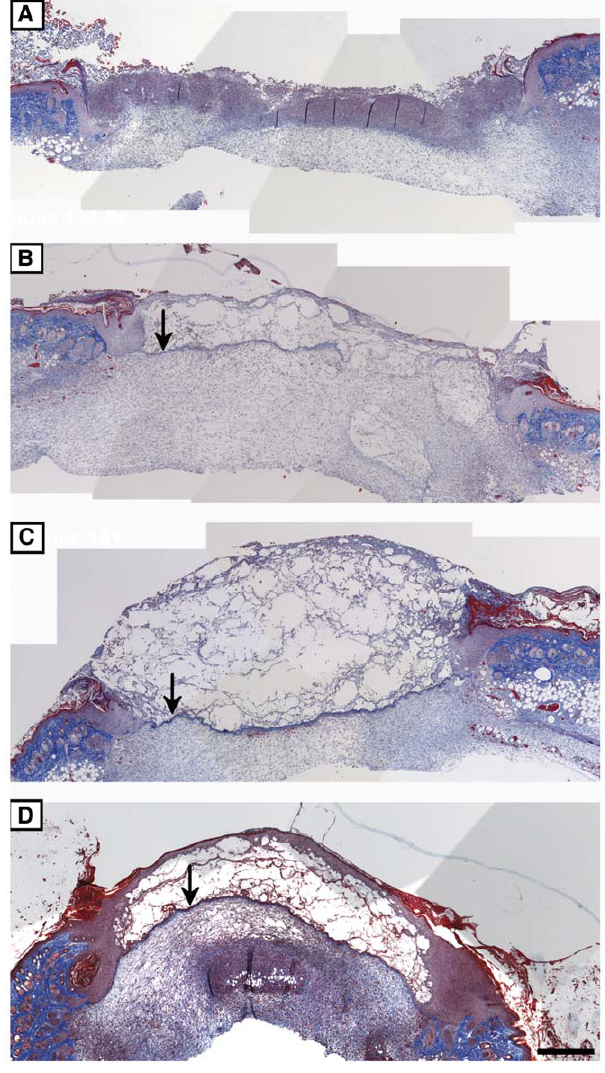
Figure 8. Effects of the peptides on collagen and basement membrane deposition during wound healing. Trichrome was used to stain wounds excised at day 5 post-injury. All the animals were injected with CY prior to injury. Representative sections of wounds treated with CMC alone (A), UN3 (B), comb1 (C) or a combination of UN3 and comb1 (D). Images were taken at 5 6 objective lens and merged using Adobe Photoshop CS2. Arrows indicate newly deposited basement membrane. Scale bar 200 m